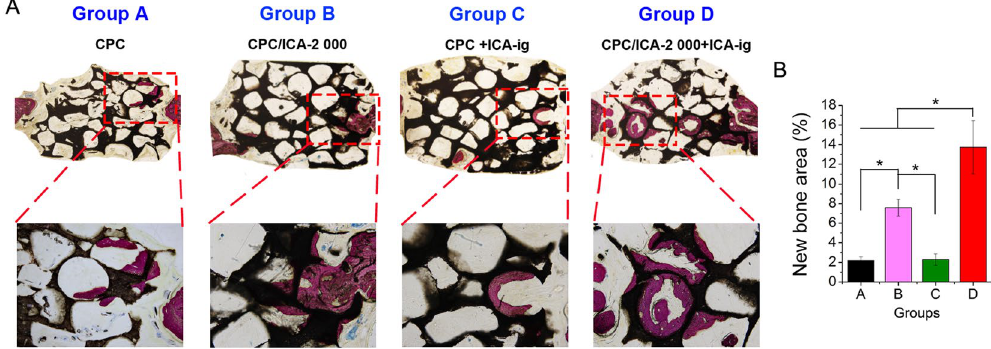
Figure 6. Histological images of newly formed bone in calvarial defects for groups CPC (Group A), CPC/ICA-2 000 (Group B), CPC + ICA-ig (Group C) and CPC/ICA-2 000 + ICA-ig (Group D) that were taken 8 weeks after the operation (Line 1: × 40; Line 2: × 100). On these nondecalcified sections, red areas represent newly formed bone, and black areas belong to undegraded CPC scaffolds. ( B ) The percentages of new bone area were assessed by histomorphometric analysis ( * p < 0.05).